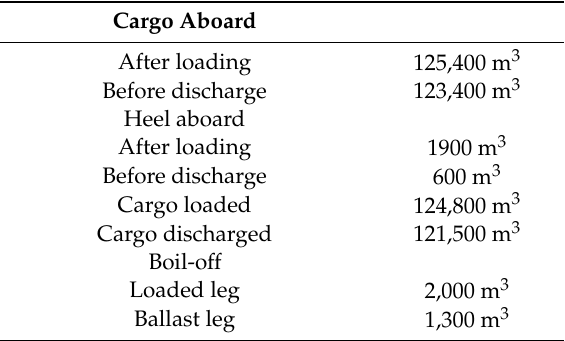
Table 2. LNG cargo handling